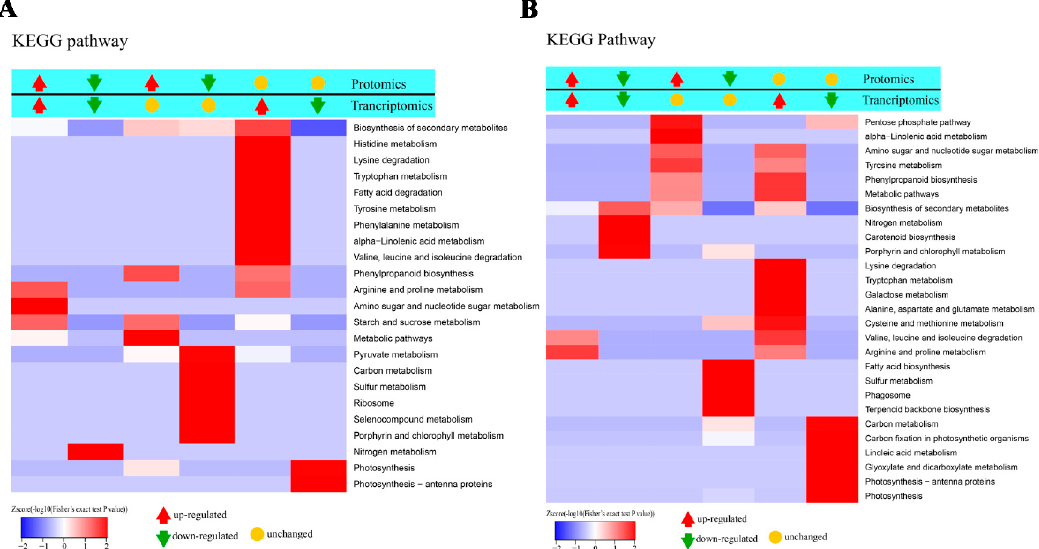
Figure 7. KEGG pathways for co-regulated genes at mRNA and protein levels in two alfalfa cultivars ( A , M12W vs. M12CK; B , M25W vs. M25CK) under waterlogged and control conditions. M12CK indicates M12 under control condition; M12W indicates M12 under waterlogged condition; M25CK indicates M25 under control condition; M25W indicates M25 under waterlogged condition.